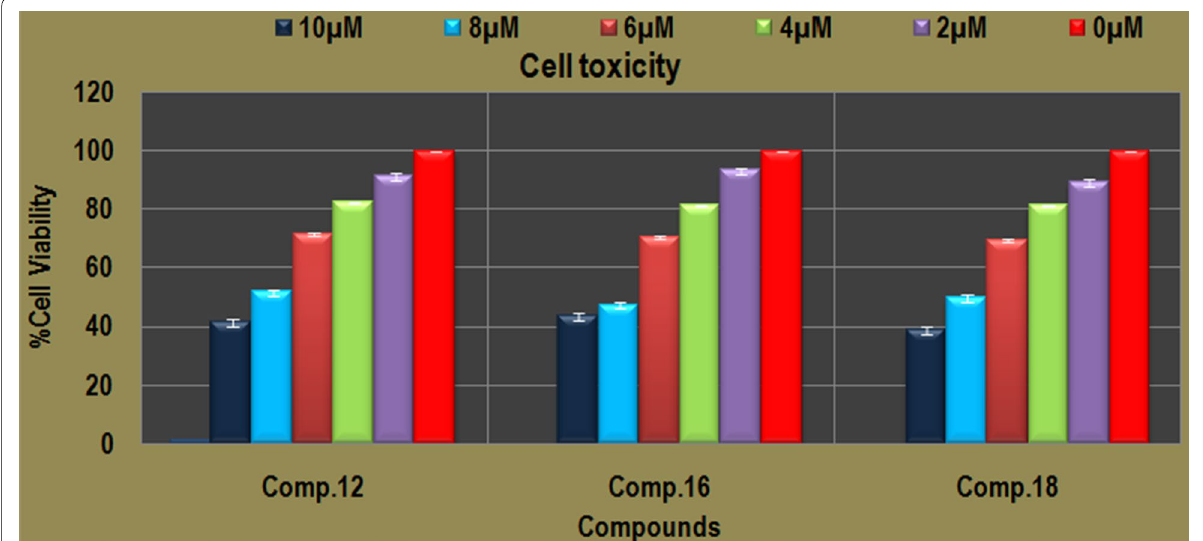
Fig. 4 HEK-293 kidney cells toxicity analysis of most active anti-carcinogenic compounds at different concentration of each